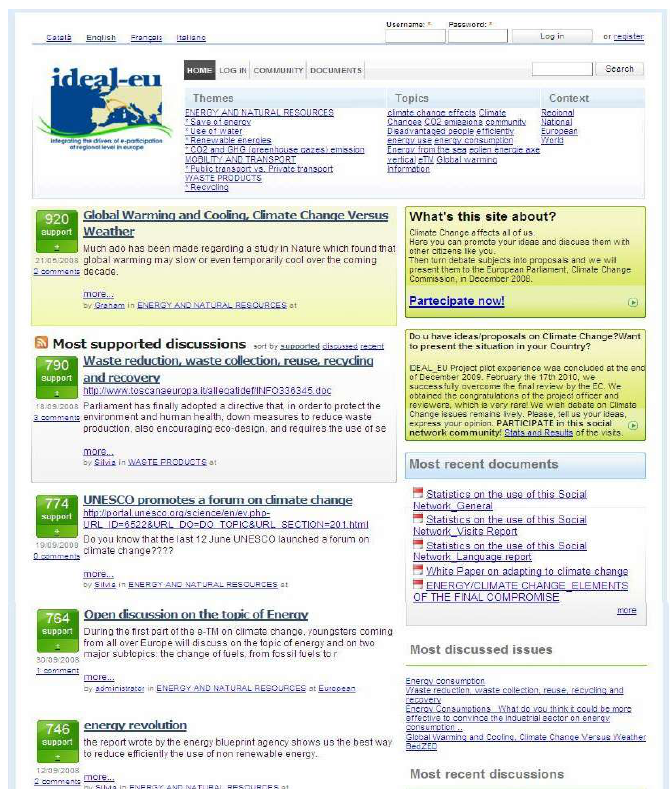
Figure 4: The IDEAL-EU Social Networking